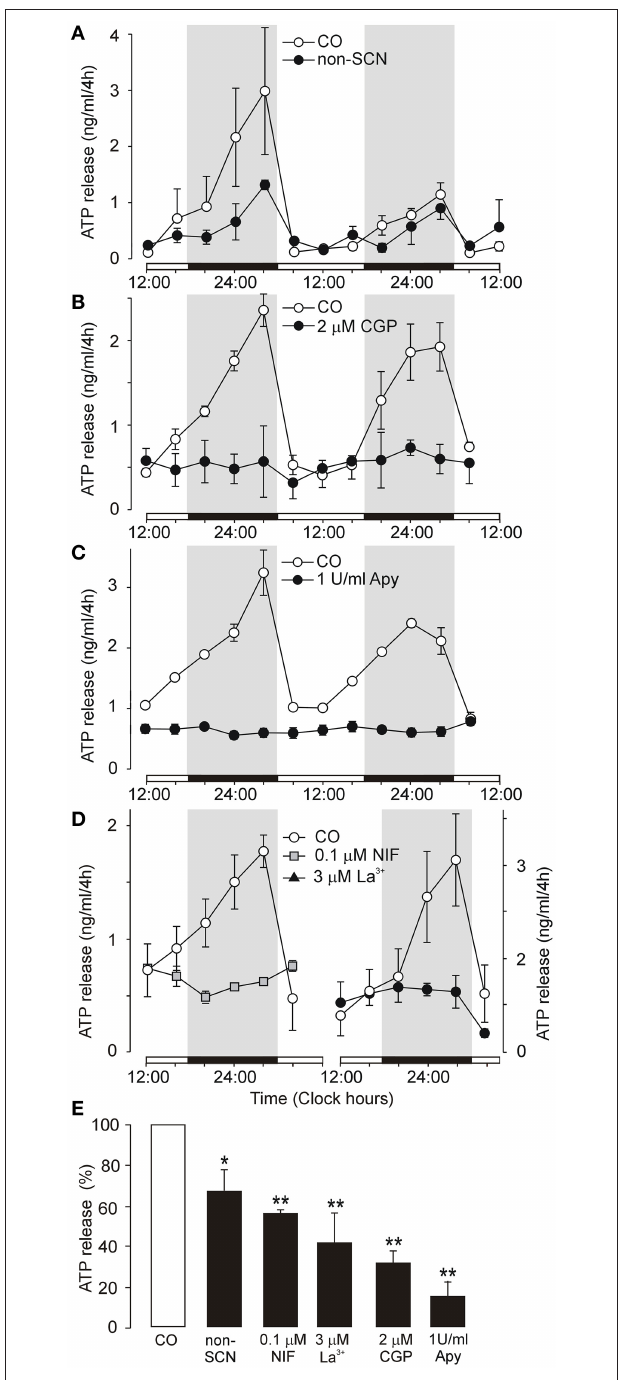
FIGURE 1 | Endogenous circadian oscillations of ATP release in organotypic cultures of the rat SCN. (A–C) Examples of an ATP rhythm measured during 2 days in control cultures (open symbols) and experimental cultures (closed symbols). Comparison of ATP rhythm in control organotypic cultures containing the SCN (CO) and organotypic cultures lacking the SCN (non-SCN) (A) . Inhibition of ATP release by a selective inhibitor of Na + -Ca 2 + exchange in mitochondria, the benzothiazepine CGP37157 (CGP) (B) , basal ATP release in the presence of ecto-ATPase, apyrase (Apy) (C) and inhibition of ATP release by the L-type Ca 2 + channel inhibitor nifedipine ( D , left panel) and